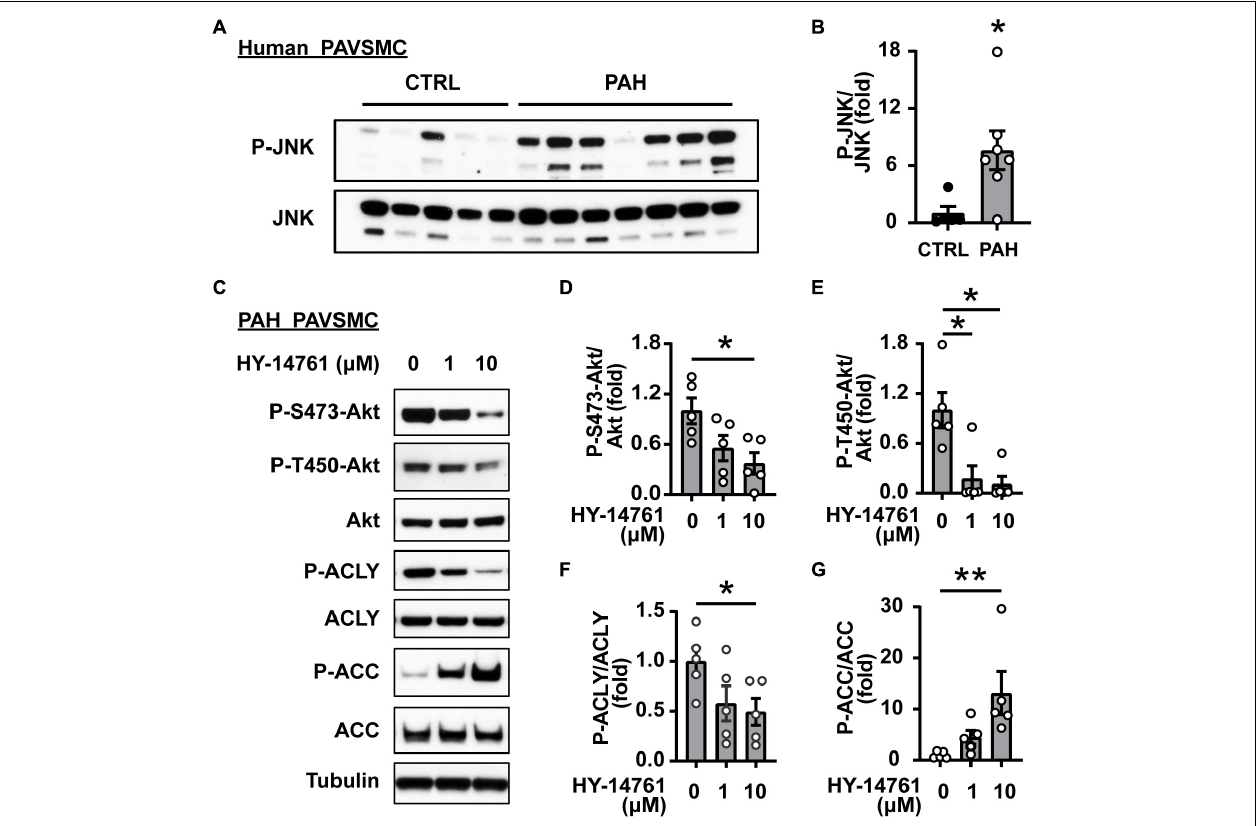
FIGURE 5 | JNK regulates Akt and lipogenic enzymes in human PAH PAVSMC. (A,B) Early passage distal human PAVSMC from five non-diseased (CTRL) and seven PAH subjects were serum deprived for 48 h and subjected to immunoblot analysis to detect indicated proteins. Immunoblots (A) and statistical analysis (B) are shown. Data are means ± SE, fold to control, * p < 0.05 by Mann–Whitney U test. (C–G) Early passage human PAH PAVSMC were treated with JNK inhibitor HY-14761 (1, 10 µ M) or vehicle (0) for 48 h followed by immunoblot analysis. Data represent fold to vehicle-treated group, n = 5 subjects/group, * p < 0.05, ** p < 0.01 by Kruskal–Wallis rank test with Dunn pairwise comparison post hoc test.